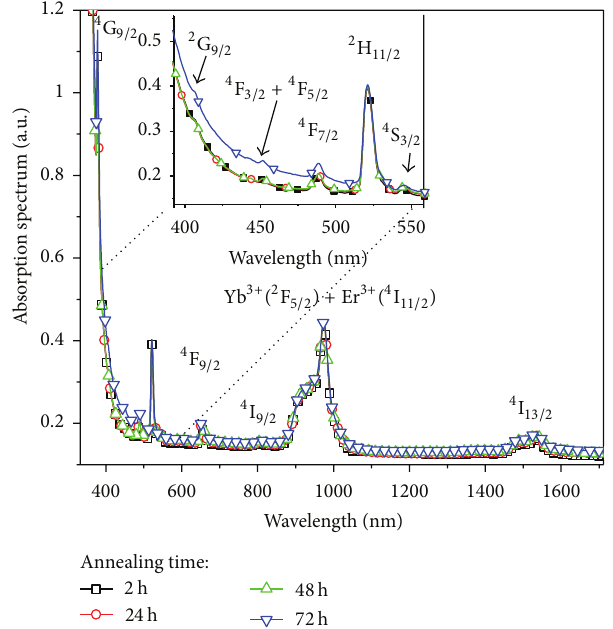
Figure 5: Absorption spectra of PGO-Er/Yb:Ag glasses containing silver NPs for different heat-treatment times